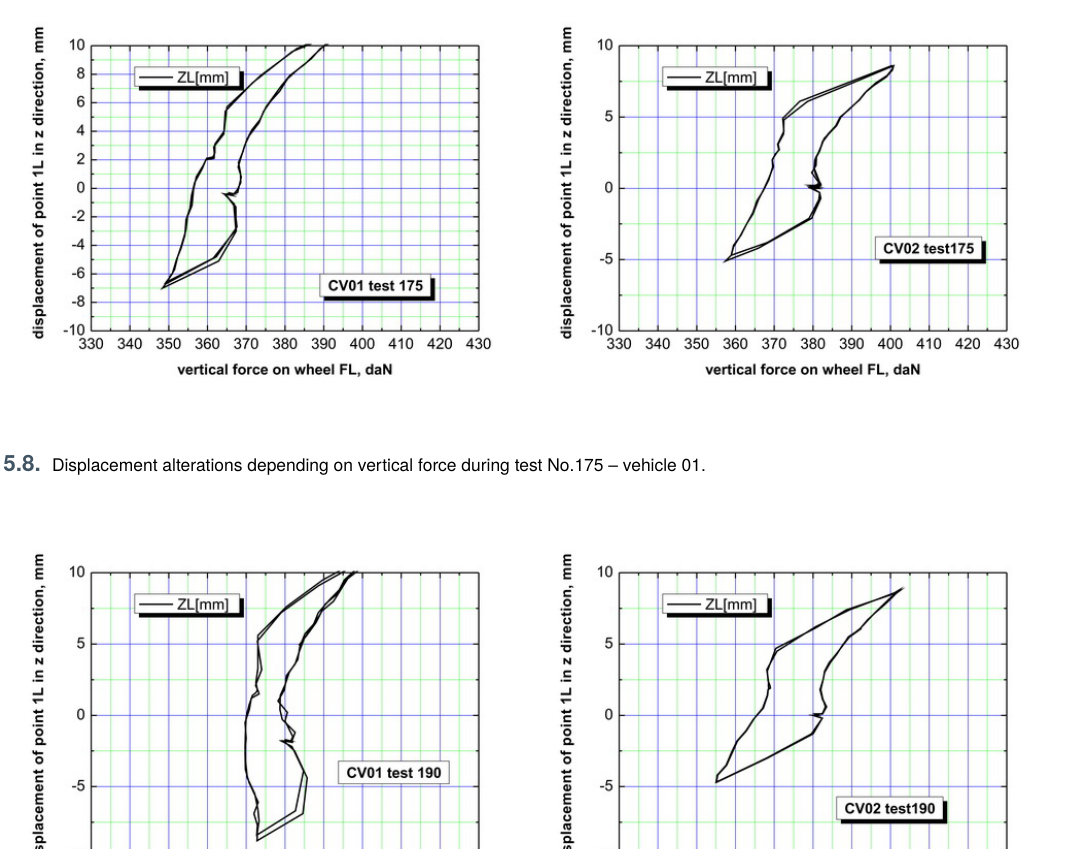
Fig. 5.7. Displacement alterations depending on vertical force during test No. 150.